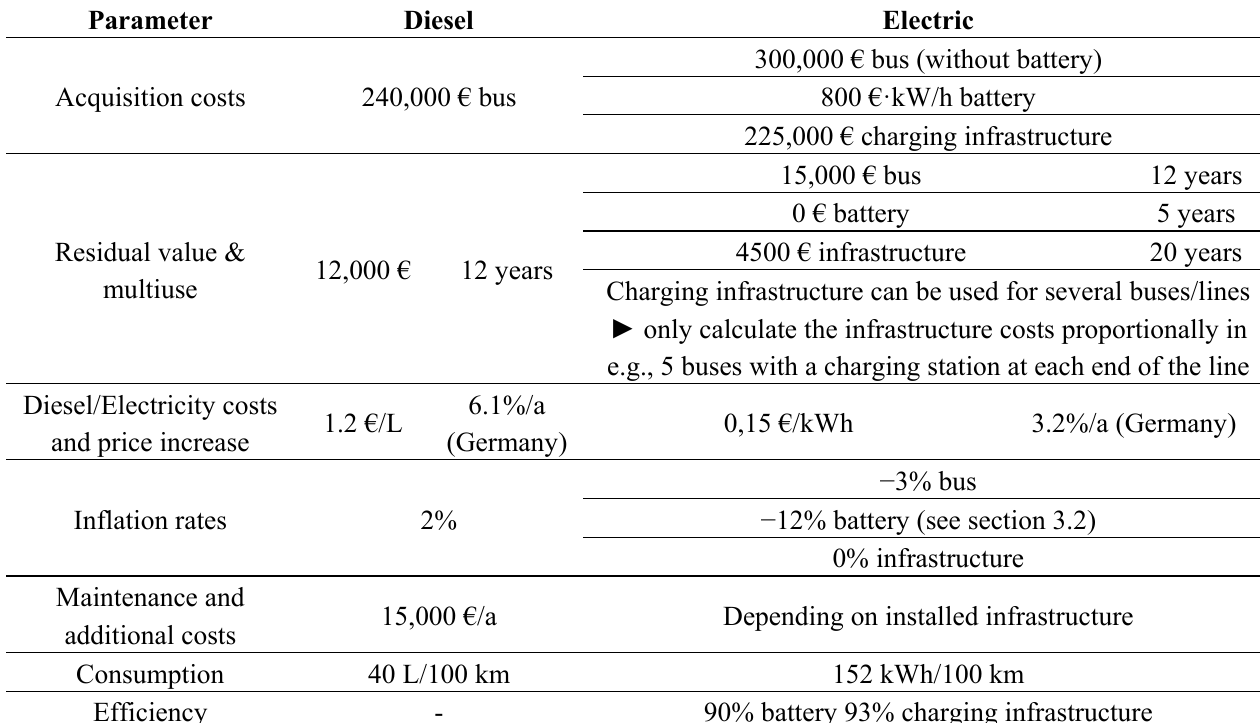
Table 1. LCC parameters for electric (90 kWh) and diesel buses.